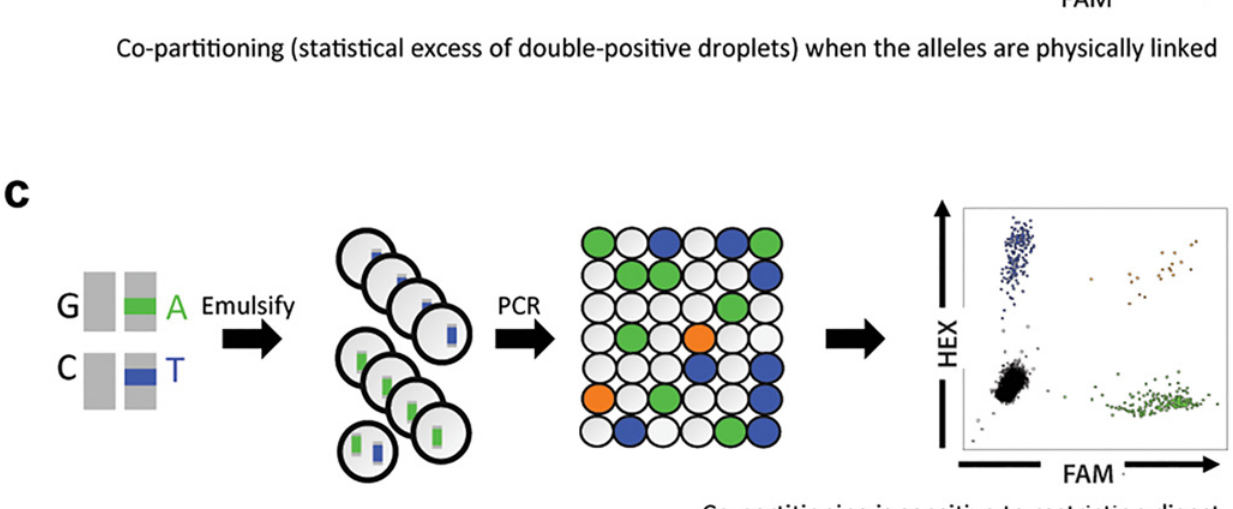
Fig 1. Drop-Phase schematic. A genomic DNA sample is emulsified into aqueous droplets in an oil-aqueous reverse emulsion. Allele-specific fluorescence probes (FAM, blue; and HEX, green) are used to detect alleles at two different loci. Following PCR, the droplets are positive for one fluorophore (blue or green), positive for both fluorophores (orange), or positive for neither fluorophore, depending on the alleles they contained at the beginning of the reaction. ( a ) Trans -configured alleles partition independently into droplets. Co-partitioning (orange) is therefore governed by chance. ( b ) Cis -configured alleles tend to co- segregate into the same droplets, because they are physically linked; co-partitioning greatly exceeds chance expectation. ( c ) Restriction digest at a site between the cis -configured alleles abolished co-partitioning of the two alleles; co-partitioning again occurs to the extent expected by chance.